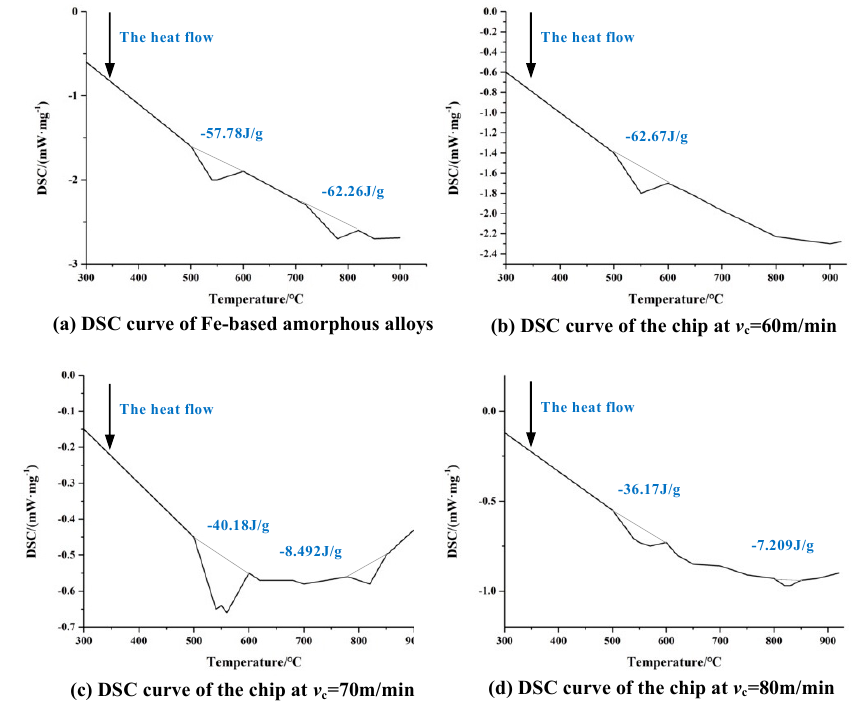
Figure 16. ( a ) DSC curves for Fe-Al-Cr-B-Si-Nb amorphous alloy. ( b ) DSC curves for chips with v c = 60 m/min, f = 0.09 mm/r, ap = 0.1 mm. ( c ) DSC curves for chips with v c = 70 m/min, f = 0.09 mm/r, ap = 0.2 mm. ( d ) DSC curves for chips with v c = 80 m/min, f = 0.09 mm/r, ap = 0.3 mm DSC curve of chips [100]. There is an obvious reduction in the area of the crystallization exothermic peak.